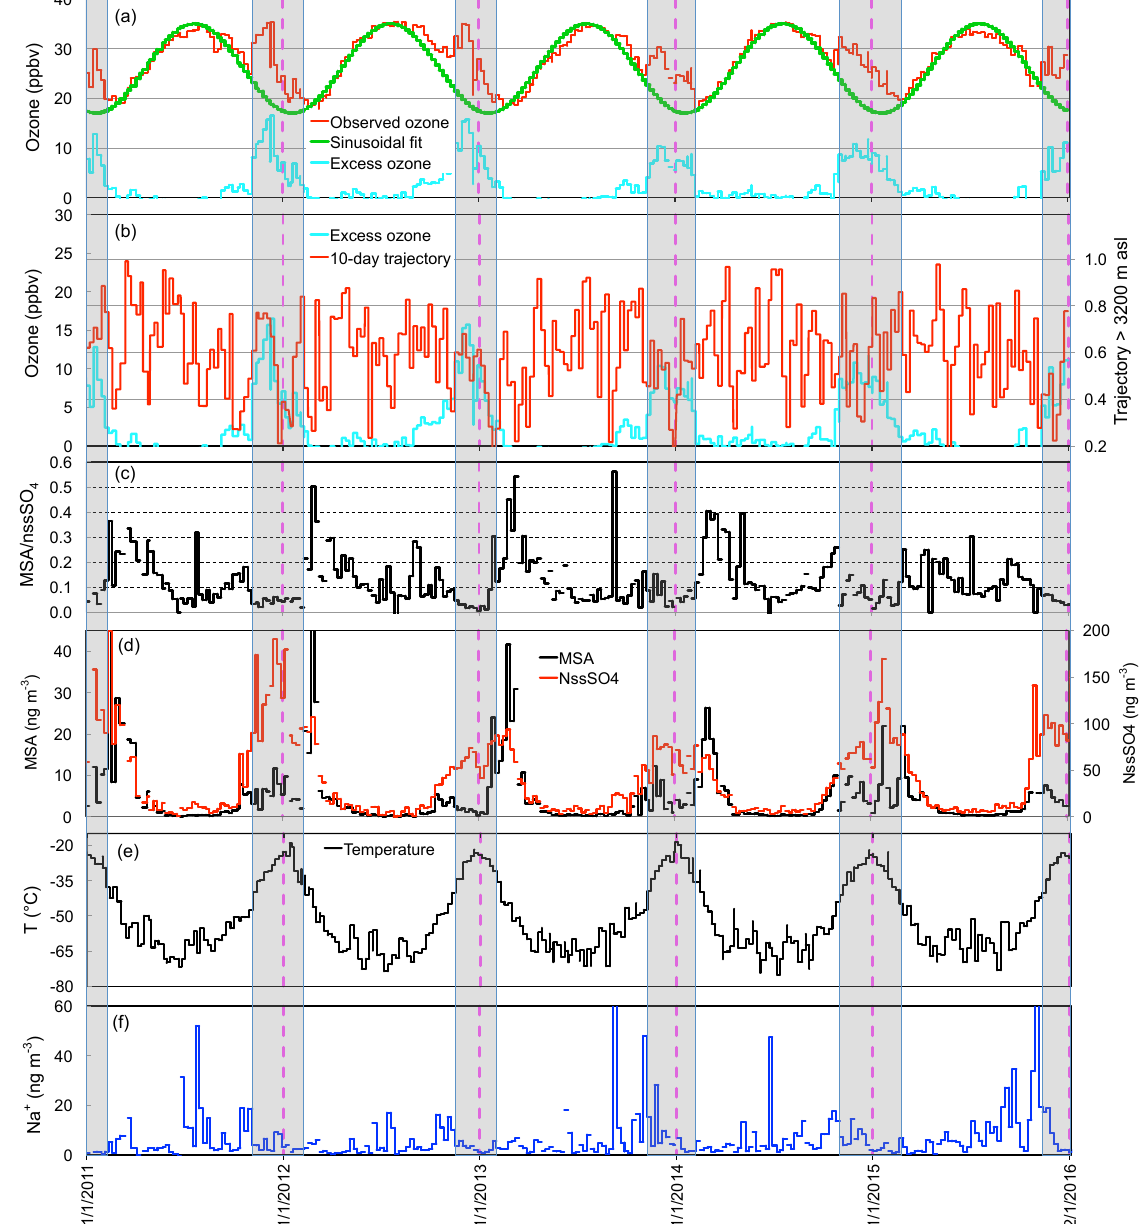
Figure 8. (a) Ozone mixing ratio corresponding to HV aerosol sampling time (red line), a sinusoidal fit of the ozone seasonal cycle (green line), and the amount of ozone present in excess (turquoise line) in summer are reported (see Sect. 3.2.3). (b) Excess ozone (turquoise line) together with the 10-day backward trajectory (arrival at 0ma.s.l.) at Concordia (see details in Legrand et al., 2017). The red curve in panel (b) is the fraction of time spent above 3200ma.s.l. by the air masses arriving at Concordia. Panels (c) and (d) show MSA / nssSO 4 mass ratio and MSA along with nssSO 4 observed on HV samples, respectively. (e) Air temperature at Concordia. (f) Sodium on HV samples. The grey area denotes the fast decreases of R MSA that coincide fairly well with the local O 3 photochemical